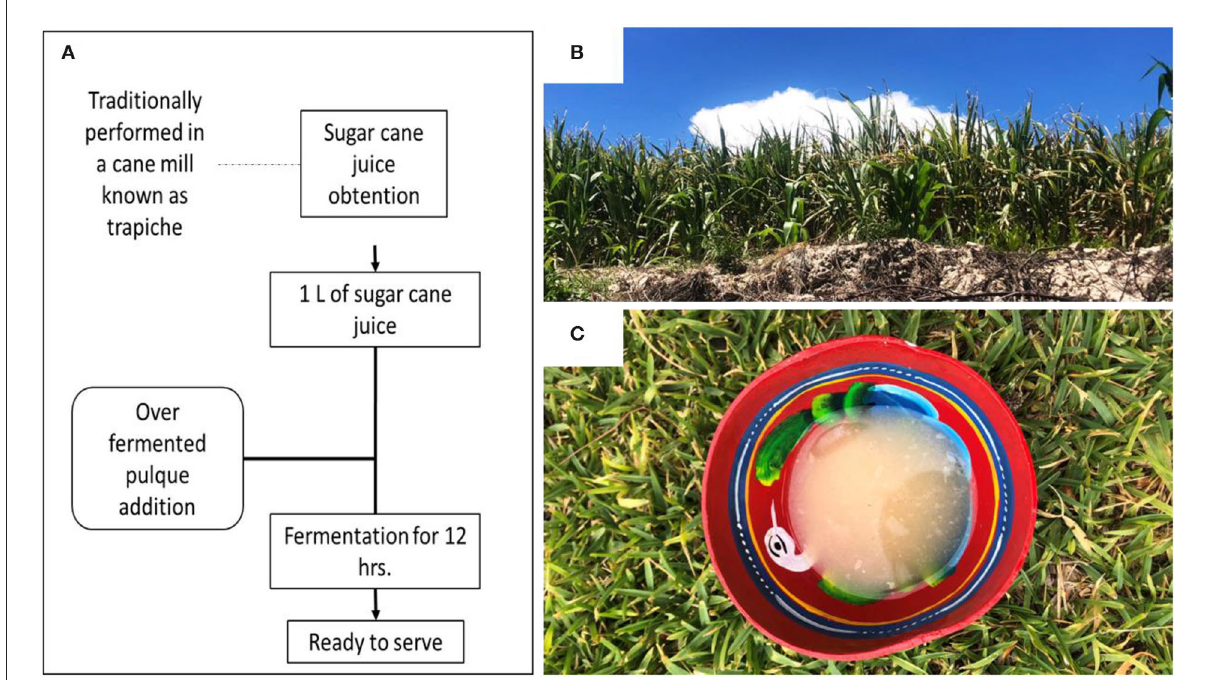
FIGURE3 Lapo production in San Gabriel Chilac. (A) A scheme for its production. (B) Sugar cane production in the community of San Gabriel Chilac. (C) Actual lapo distributed in San Gabriel